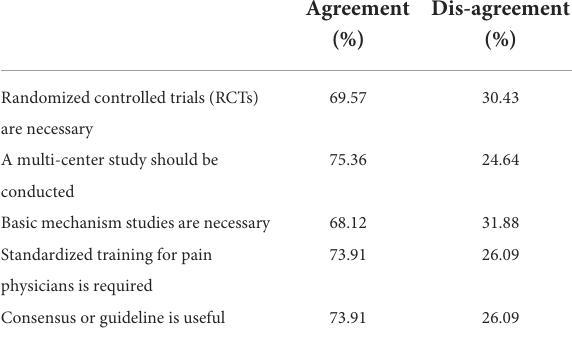
TABLE 3 Prospects of st-SCS for the treatment of